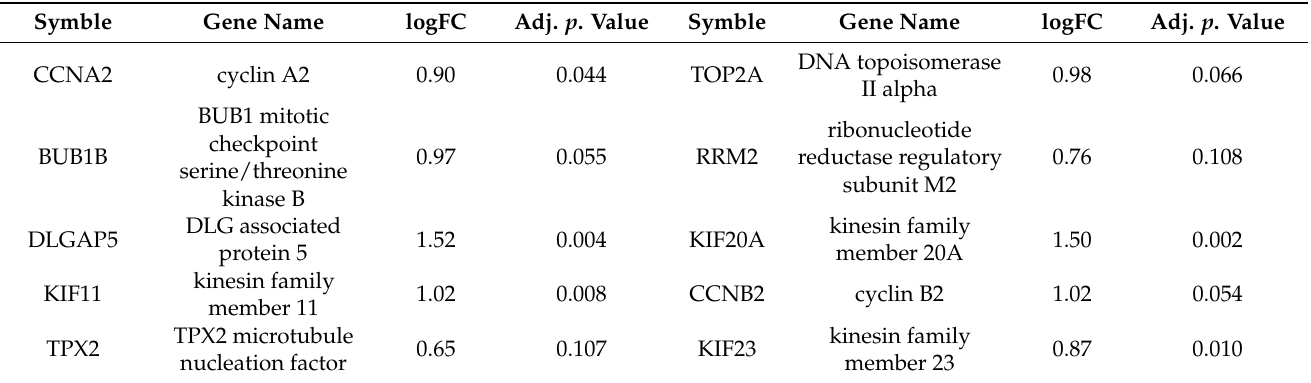
Table 1. Top 10 hub genes of turquoise module screened out by Cytoscape.